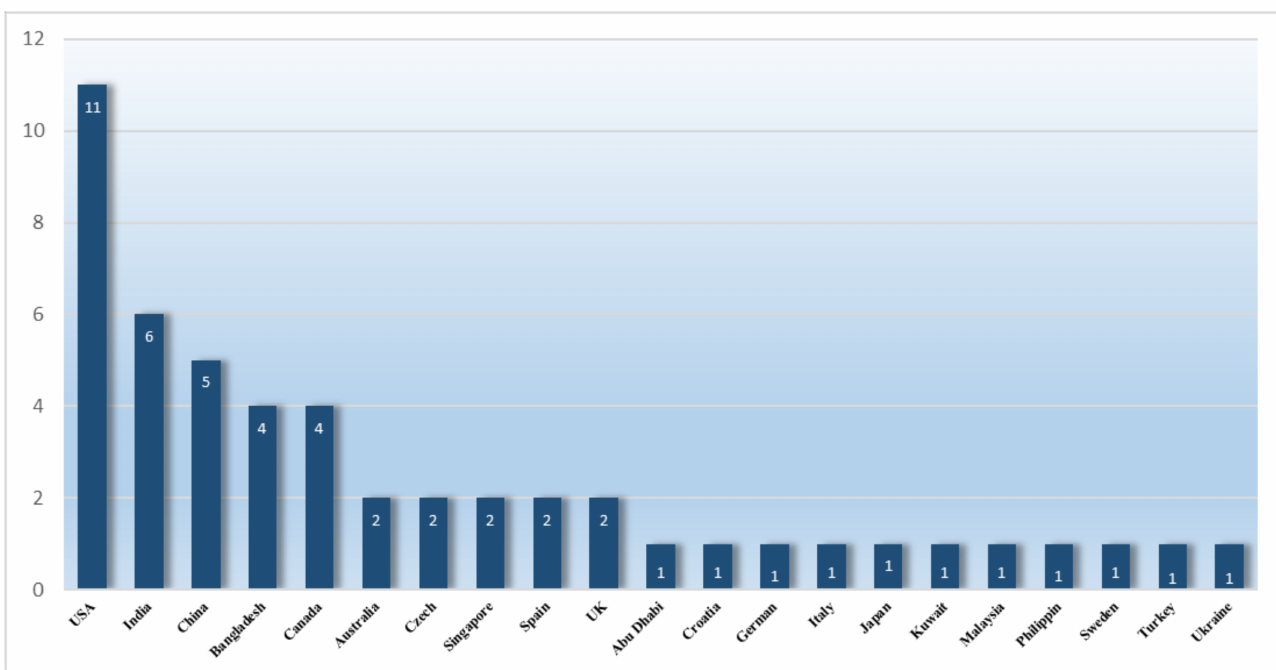
Figure 3. The results of the geographical distribution classification of papers after 2nd step.